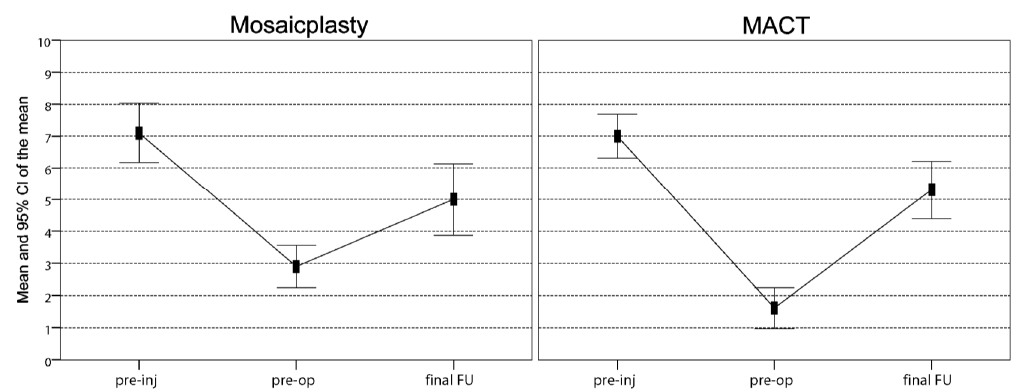
Figure 2. Comparison of the Tegner scores achieved at a final follow-up of 12 years. In both groups, scores improved significantly from the pre-operative level to the final follow-up, even though the mean activity level remained significantly lower vs. pre-injury. No differences were found in sports activity levels between the two groups. FU, follow-up; Pre-inj, pre-injury; Pre-op, pre-operative. Two patients of the mosaicplasty group failed (one with four plugs and one with three plugs) and were treated with MACT 2 years after the treatment, fixing a 10% reoperation rate. At the final